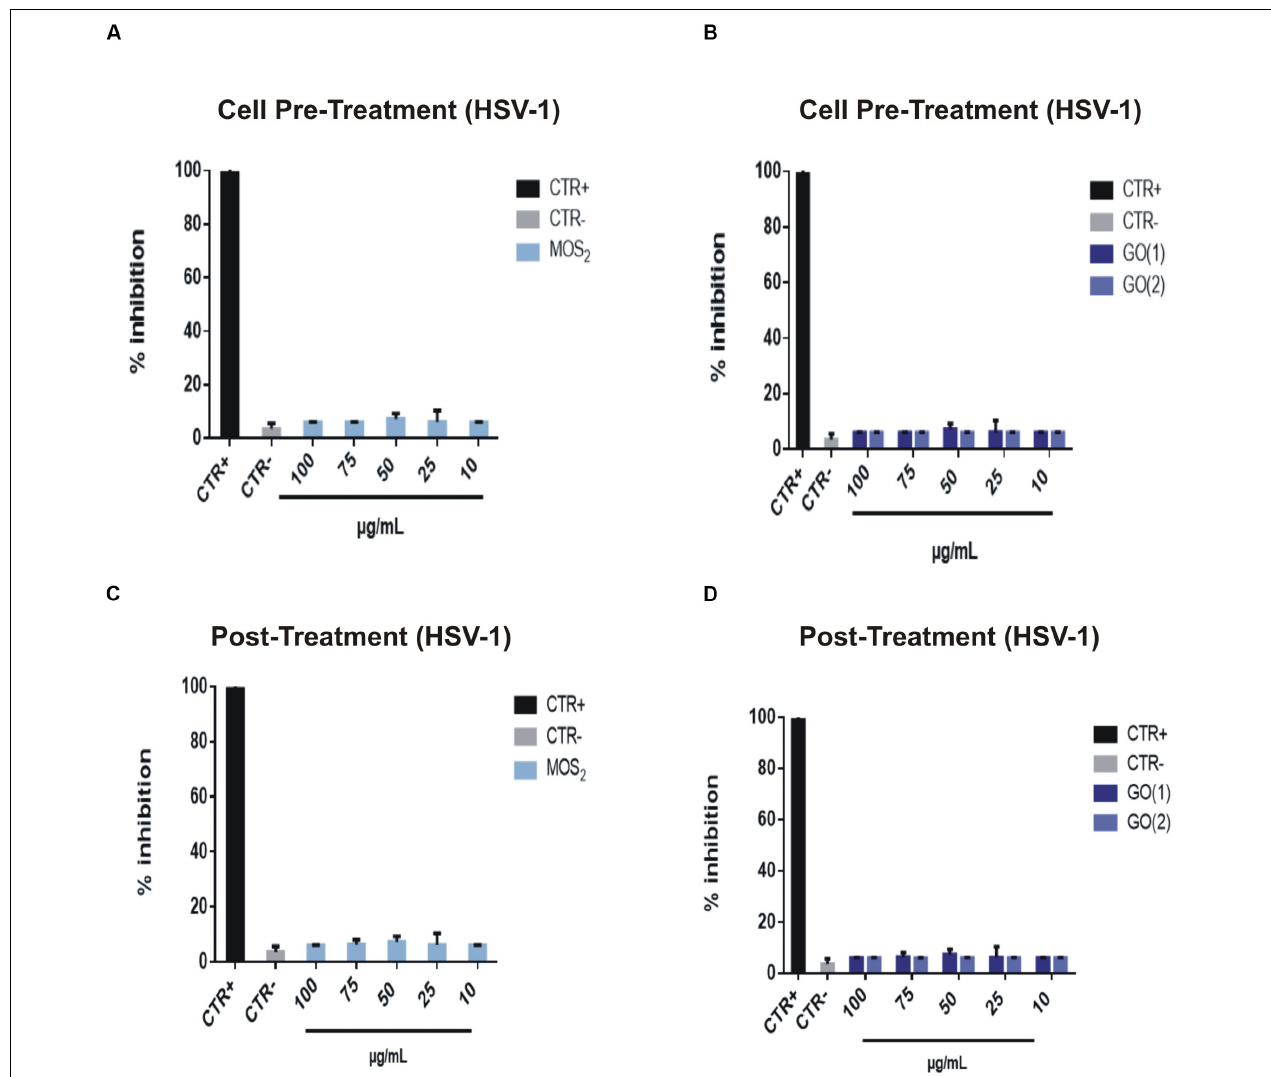
FIGURE 10 | Cell pre-treatment and post-treatment assay after treatment with MoS 2 and GO NSs. Vero cells were treated with MoS 2 (A) and GO NSs (B) , and then infected with HSV-1 in the cell pre-treatment assay. Infectivity inhibition experiment in the post-treatment scheme. (C) After addition of MoS 2 NSs, (D) or treatment with GO NSs. No antiviral activity was reported for both NSs in the two antiviral experiments. Cells and cells infected with virus represented the positive (Acyclovir) and negative controls, respectively. The data statistical error is the standard deviation of three independent experiments. P -value is less than